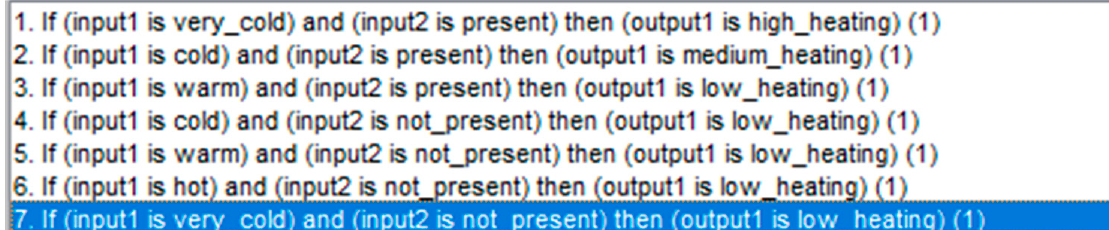
Figure 7. Ventilation level dependency on temperature and presence.